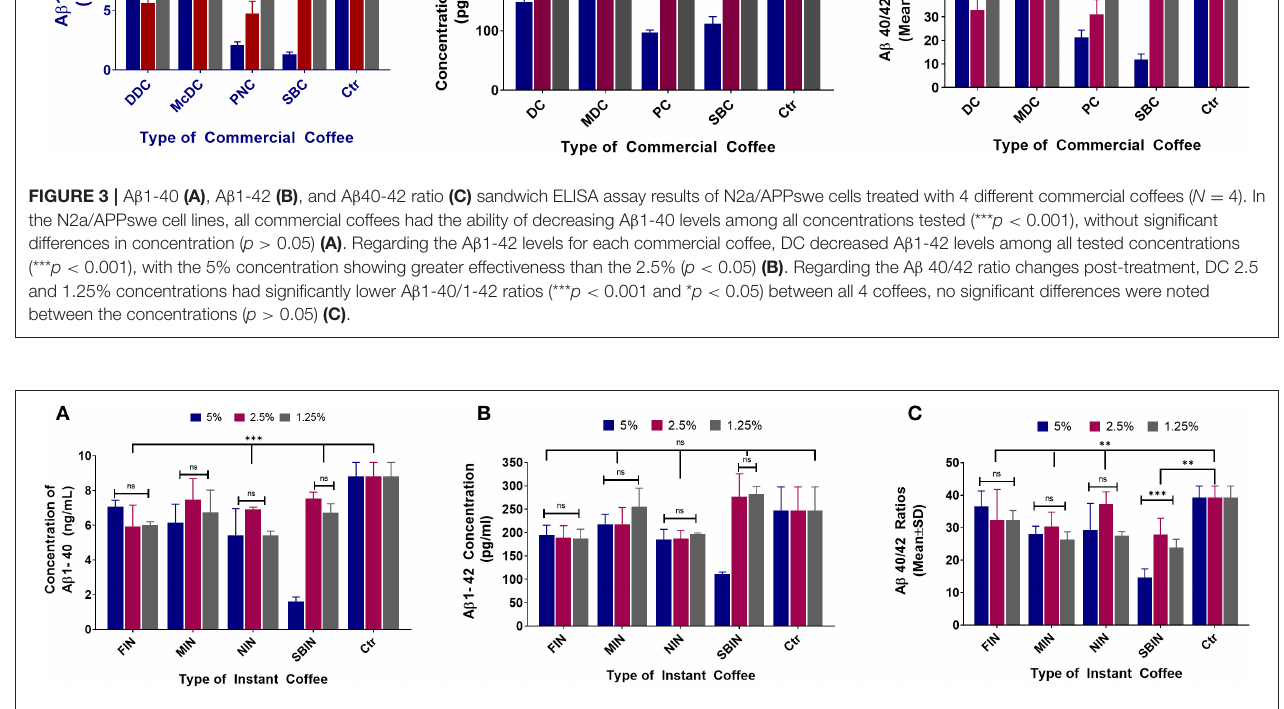
FIGURE 4 | A β 1-40 (A) , A β 1-42 (B) , and A β 40-42 ratio (C) sandwich ELISA assay results of N2a/APPswe cells treated with 4 different instant coffees, which were purchased and were prepared according to the package instructions (the same method was used to treat N2a/APPswe cells as the commercial coffees) ( N = 4). In the A β 1-40 results of each coffee treatment, FIN and MIN decreased A β 1-40 levels among all tested concentrations (*** p < 0.001 and ** p < 0.01, respectively), without significant differences among concentrations ( p > 0.05) (A) . The A β 1-42 levels post-treatment with different instant coffees elucidated that FIN